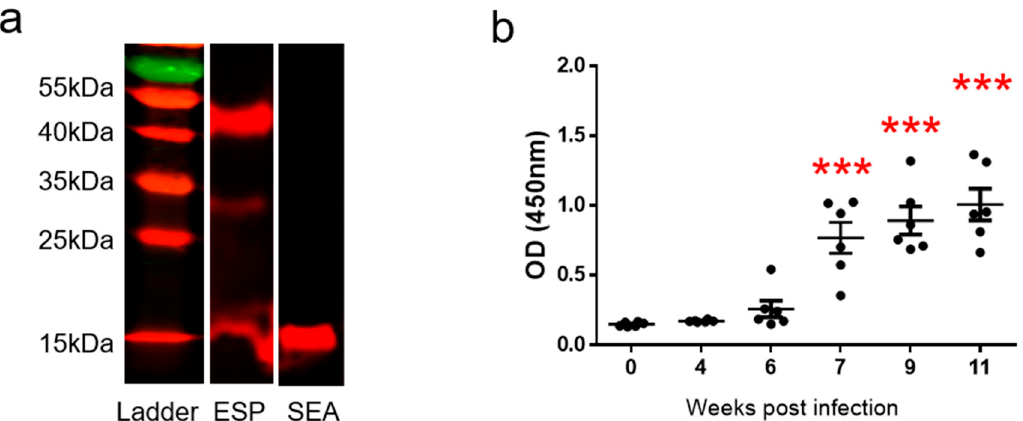
Figure 3. ( a ) Western blot analysis using mouse anti-SjILP serum to probe ESP (egg secreted proteins) and SEA (soluble egg antigens). ( b ) IgG antibody response against recombinant SjILP antigen in the sera of BALB/c (laboratory bred mouse strain of albino genotype c) mice at 0, 4, 6, 7, 9, and 11 weeks post-challenge infection with 16 Schistosoma japonicum cercariae. Statistical significance was determined using one-way ANOVA. (*** p < 0.0001).